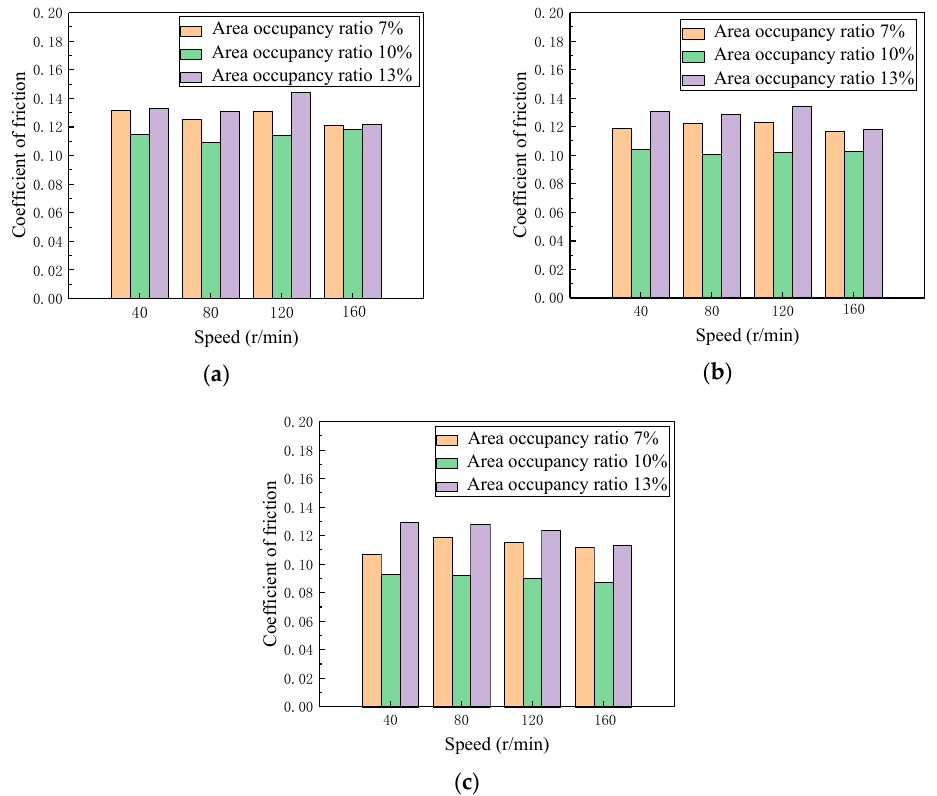
Figure 12. Friction coefficients of the surface of three textured specimens with different area occupancy ratios: ( a ) triangular textured surface; ( b ) triangular groove textured surface; ( c ) semicircular ring textured surface.